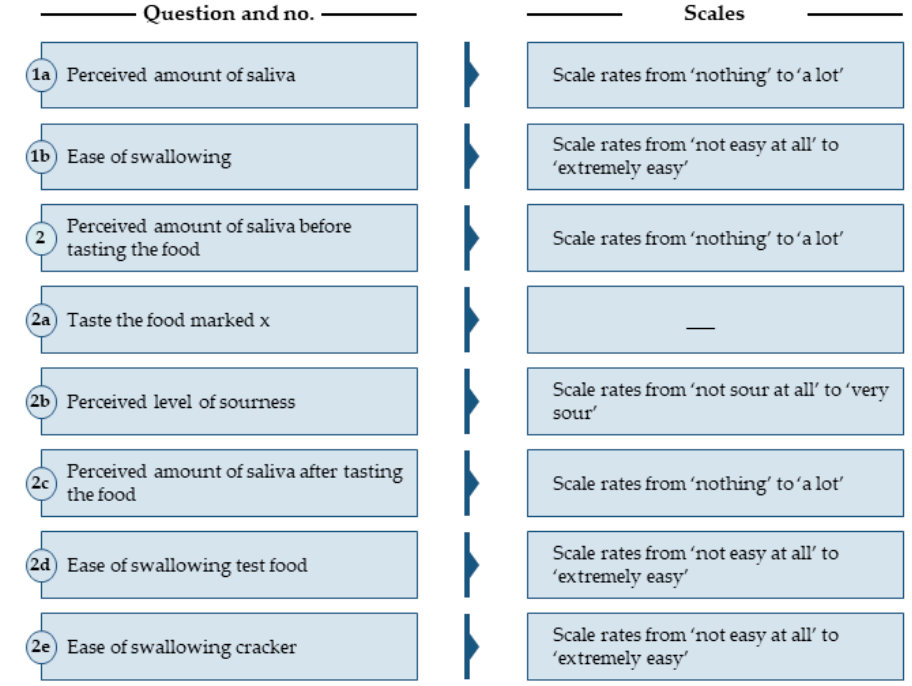
Figure 1. Questions 1a and 1b formed the baseline for questions 2a–2e. These questions were repeated in all eleven questionnaires, i.e., for each product the subjects consumed. The participants made a mark on a scale measuring 12 cm in length.